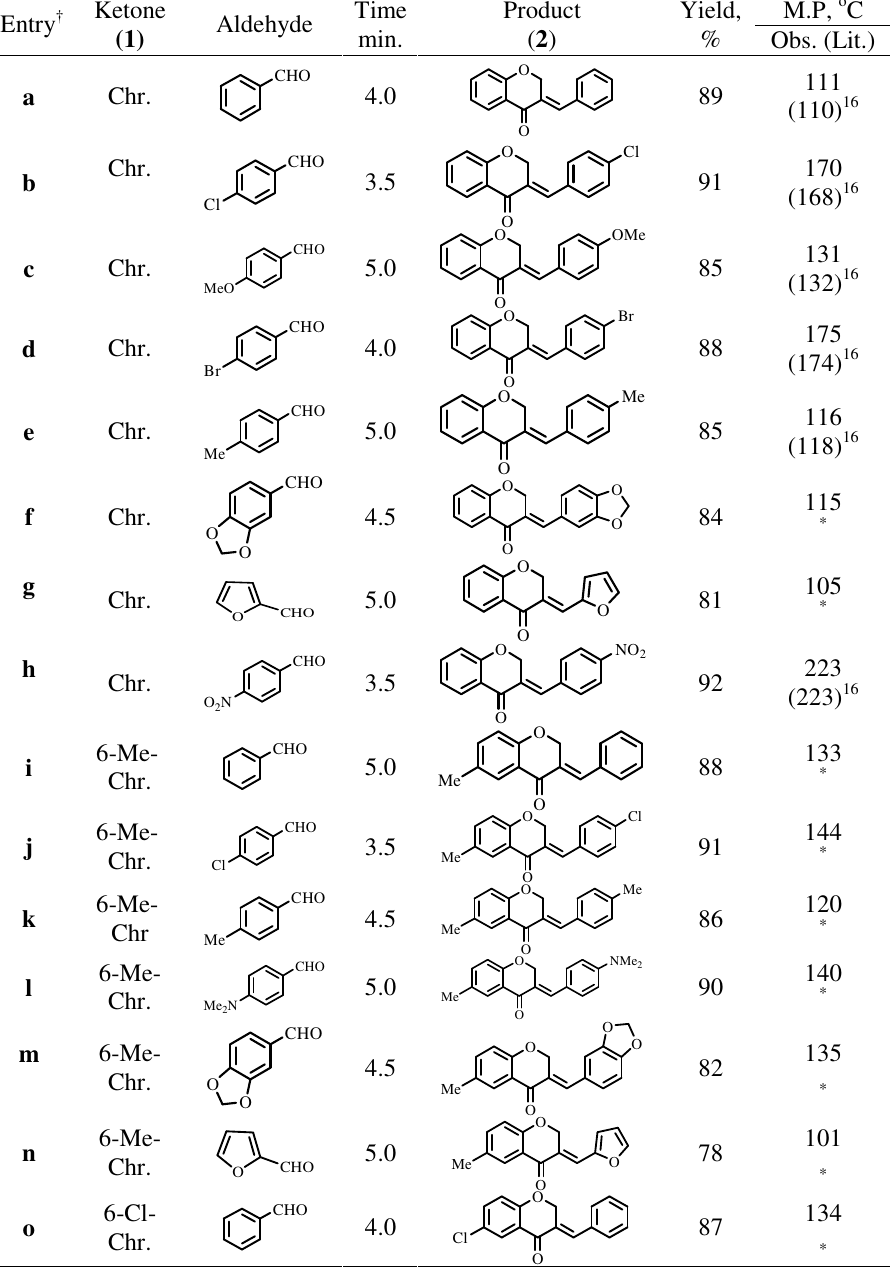
Table 1. Microwave assisted synthesis of E -3-arylidenechroman-4-ones and E -3-arylidene-